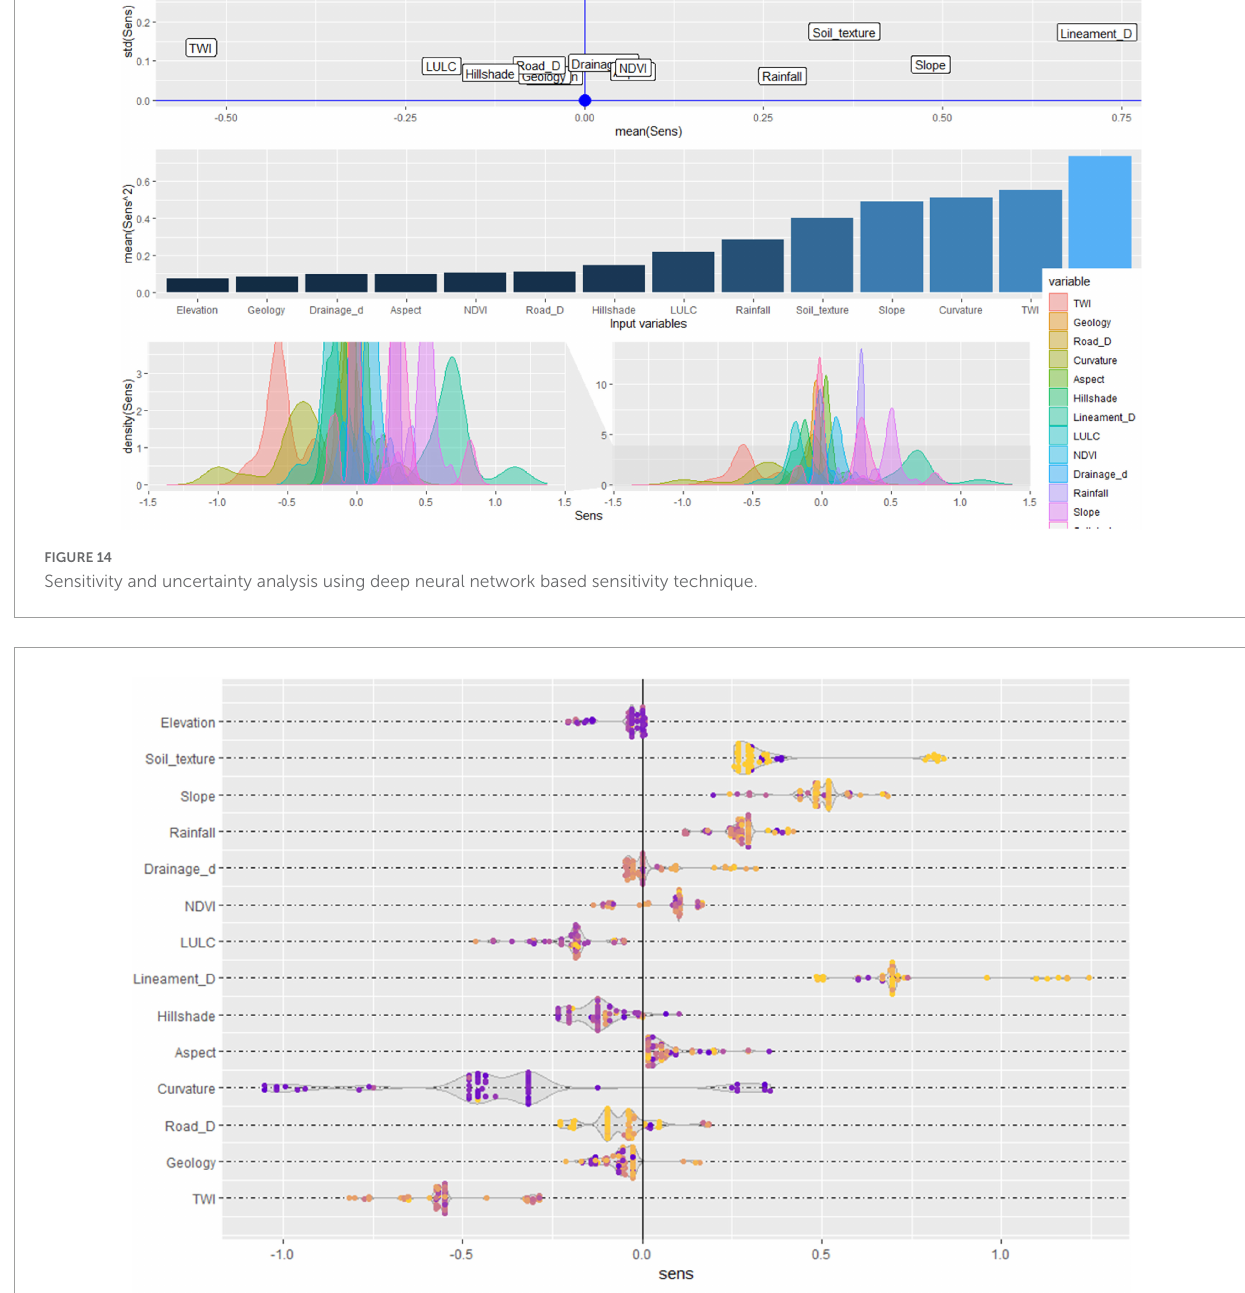
low to very high value to these component, applied grid search techniques. We set the model to produce top 100 models for DNN and unlimited for RF model as per the accuracy of training and testing data. Then, we arrange all the models based on the value of misclassification. Thus, we obtained 100 models for DNN and 132 models for RF algorithms to predict LSM. Figures 6 , 7 show